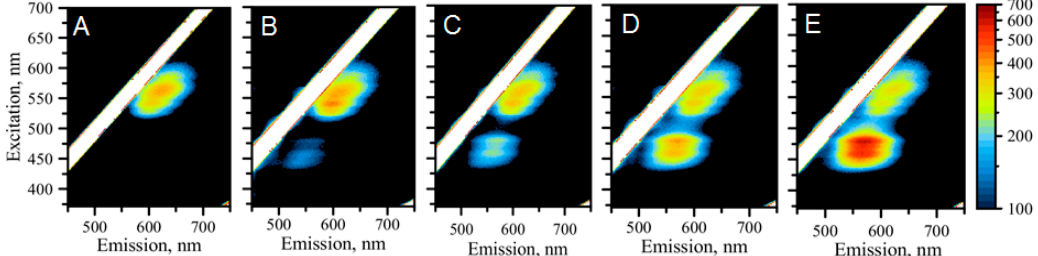
Figure 3. The collection of 2D spectra showing changes upon progressive addition of molar equivalent of miR-21 to C 12 -loop-miR21-probe with AgNCs. ( A ) 0 molar equivalent; ( B ) 0.25 molar equivalent; ( C ) 0.50 molar equivalent; ( D ) 0.75 molar equivalent; and ( E ) 1.00 molar equivalent.